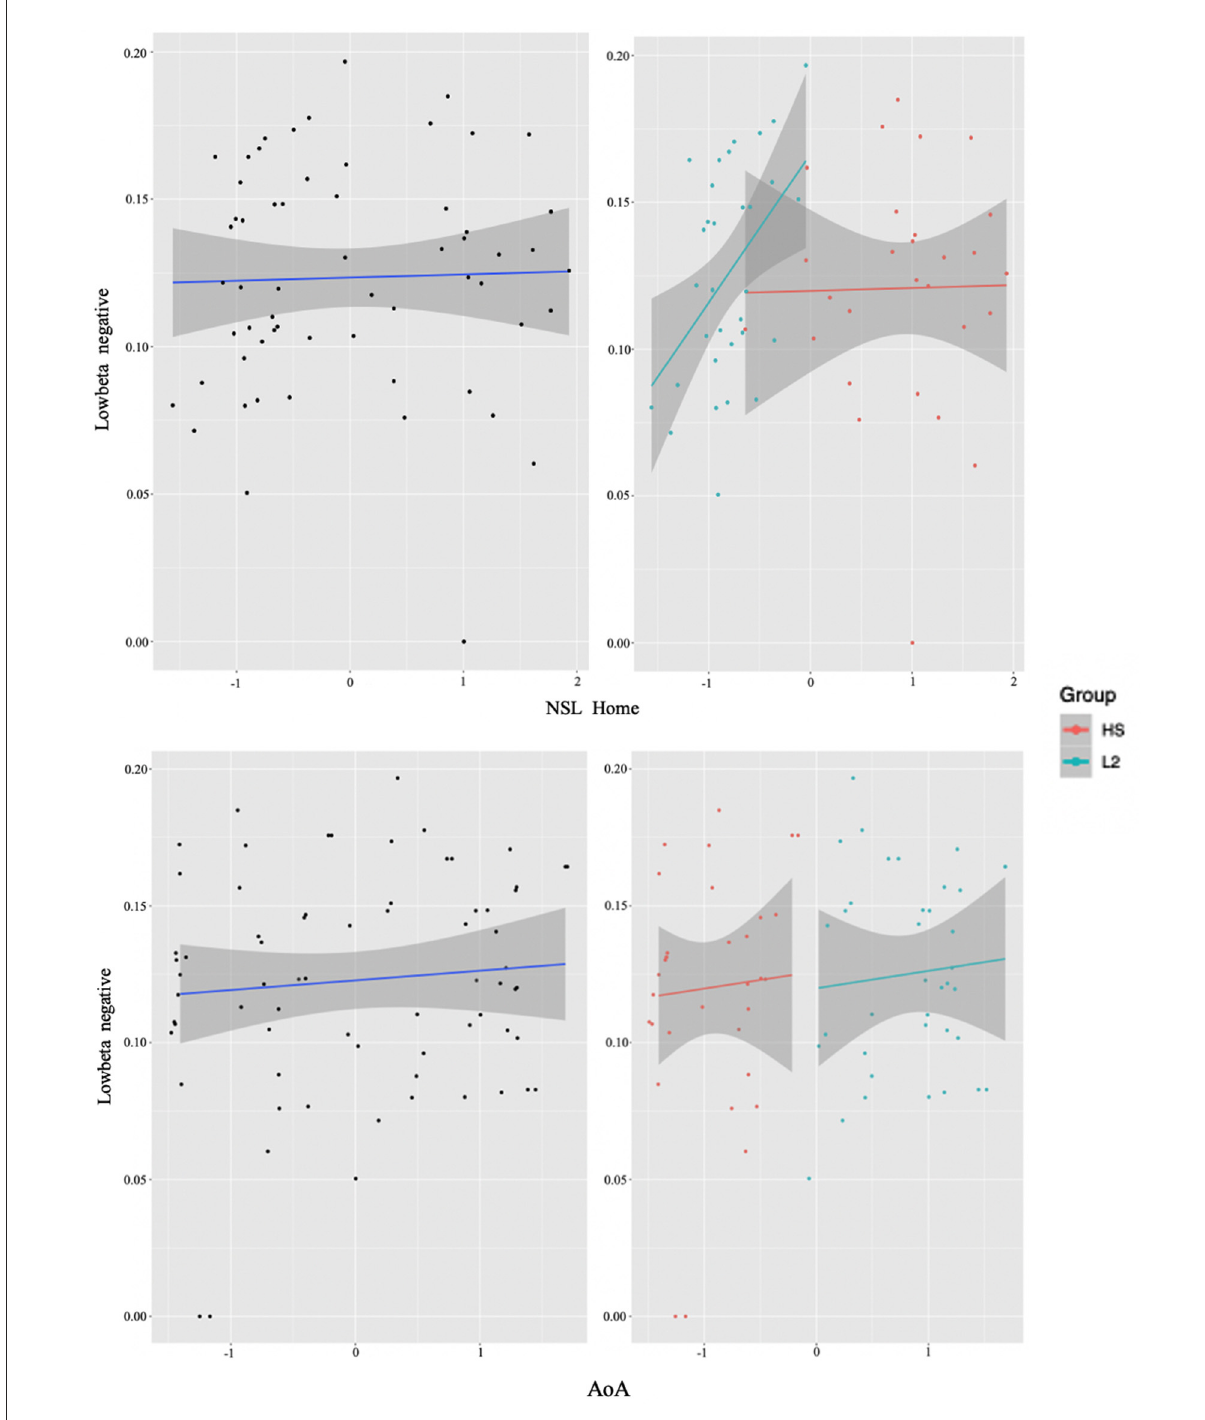
FIGURE3 Collapsed group analysis results. The two figures on the left represent the correlation between experience factors (NSL Home top and AoA bottom) and low beta power from the whole collapsed dataset (units on both axes are normalized ones: x -axes age and y -axes power) (see Section Identifying time-frequency clusters of interest for clusters of interest). In the two right figures, the individual data points, representing the participants, have been sorted out into the two groups (HS for the heritage speakers of Italian and L2 for the L2 learners), where again the NSL Home interaction is on the top and AoA on the bottom. Notice how the two groups cluster separately, with little to no mixing between them. In the two right figures, the L2 learner group (L2) is represented in blue and the HS group (HS) in